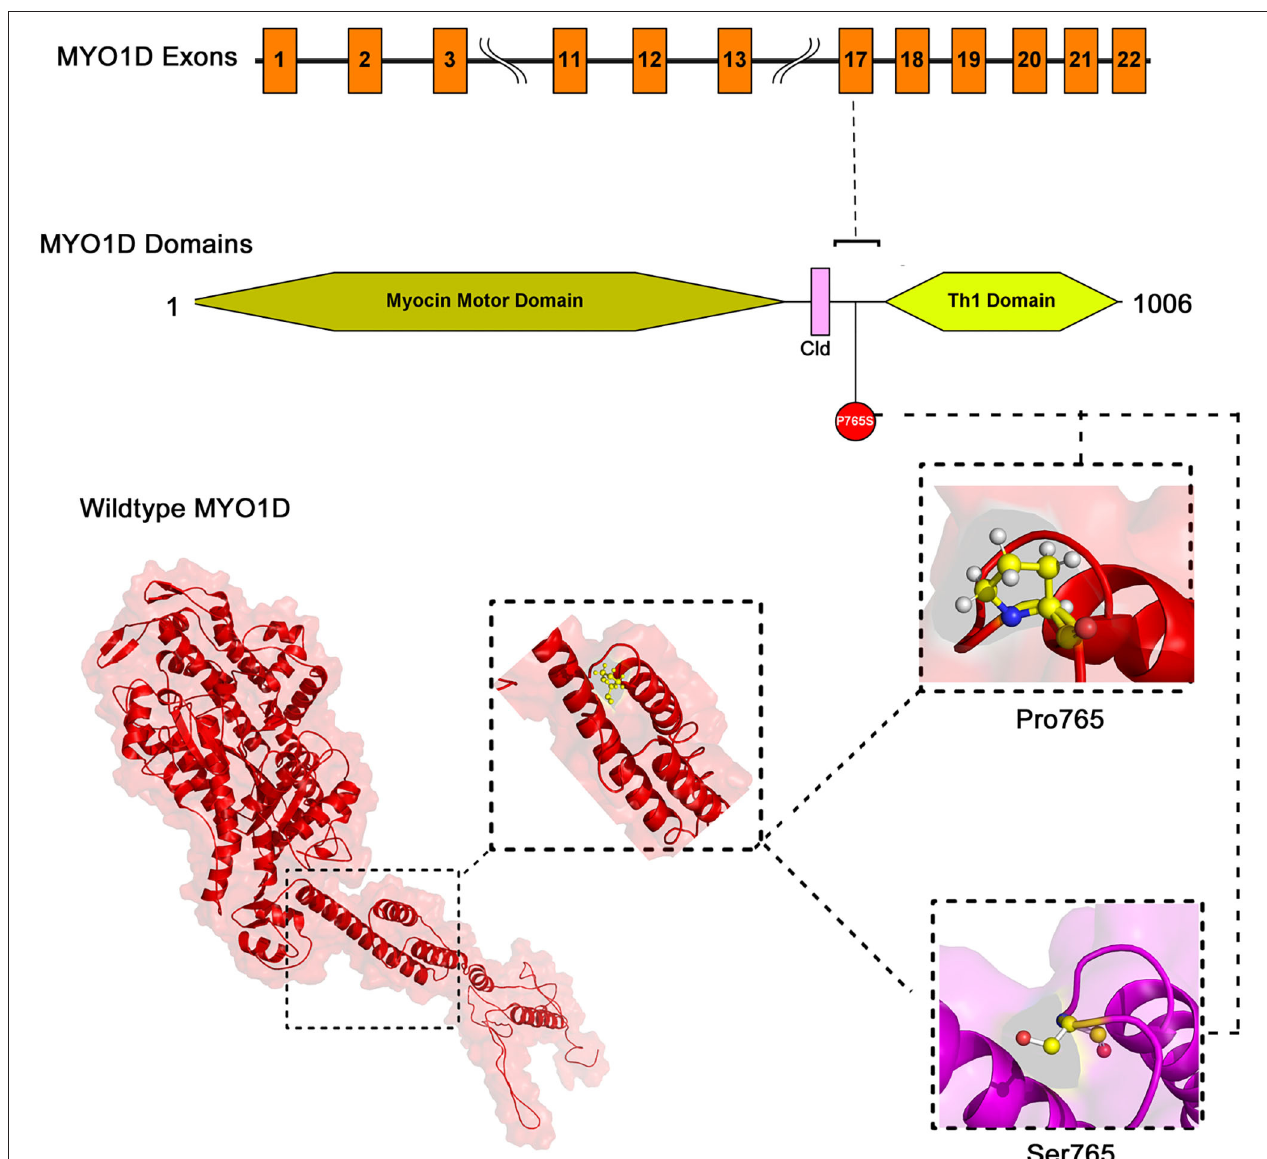
FIGURE 3 | The exonic, functional domain and 3D structural annotation of MYO1D (Pro765Ser)